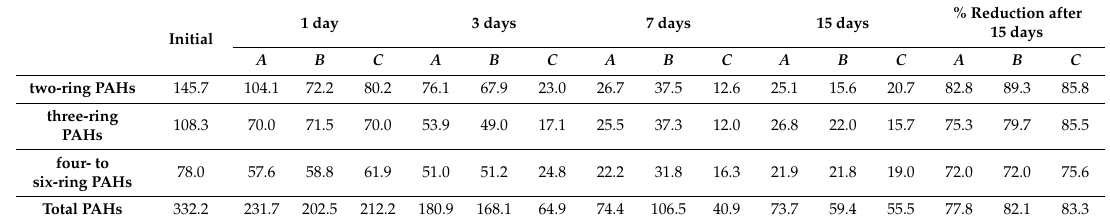
Table 3. Evolution of PAH content (mg / kg) in the six pilot-scale parcels. The relative standard deviations (RSD) for PAHs were in a range, from a minimum of 1% for Benzo[a]anthracene to a maximum of 9% for Naphthalene. 1 day 3 Initial